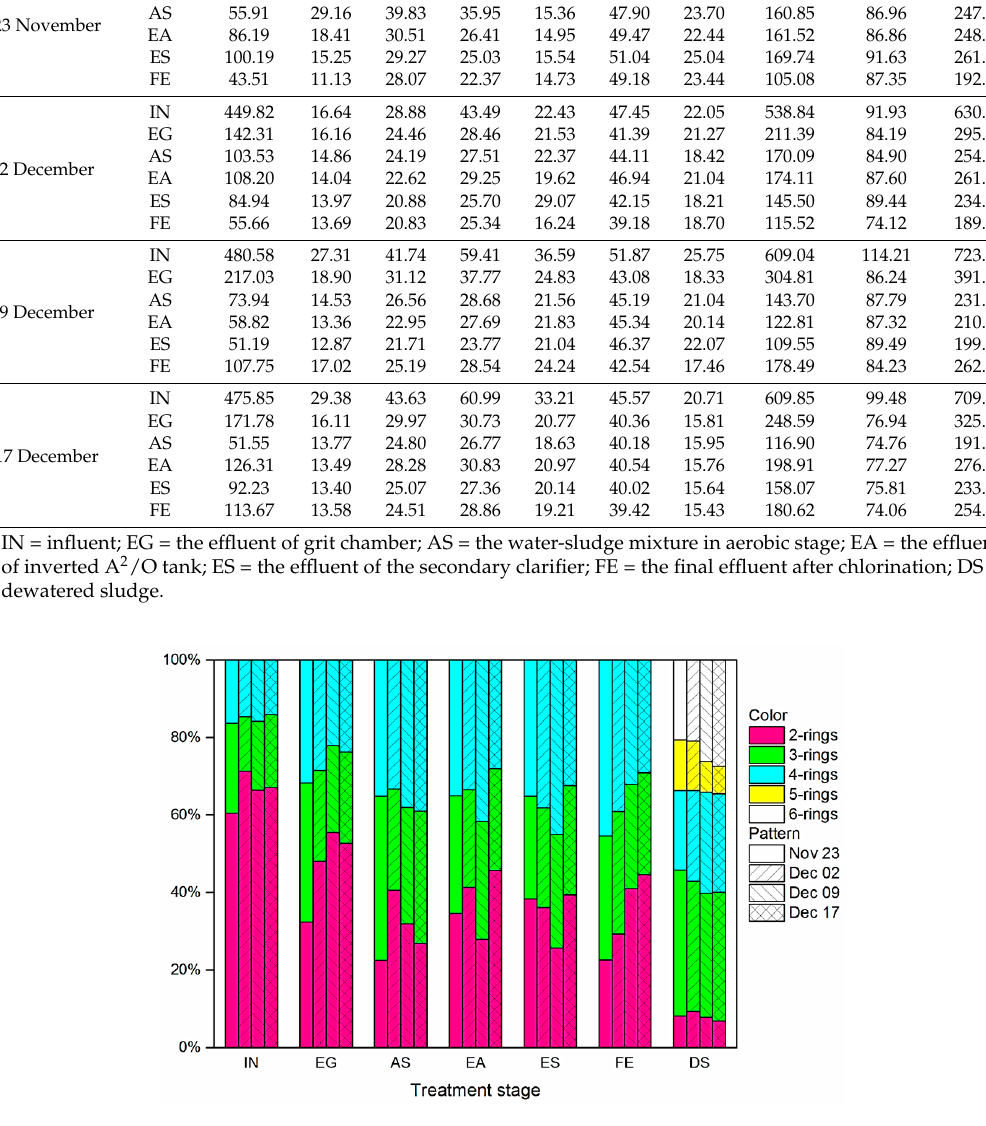
Figure 2. Distribution profiles of PAHs at the different treatment stages.